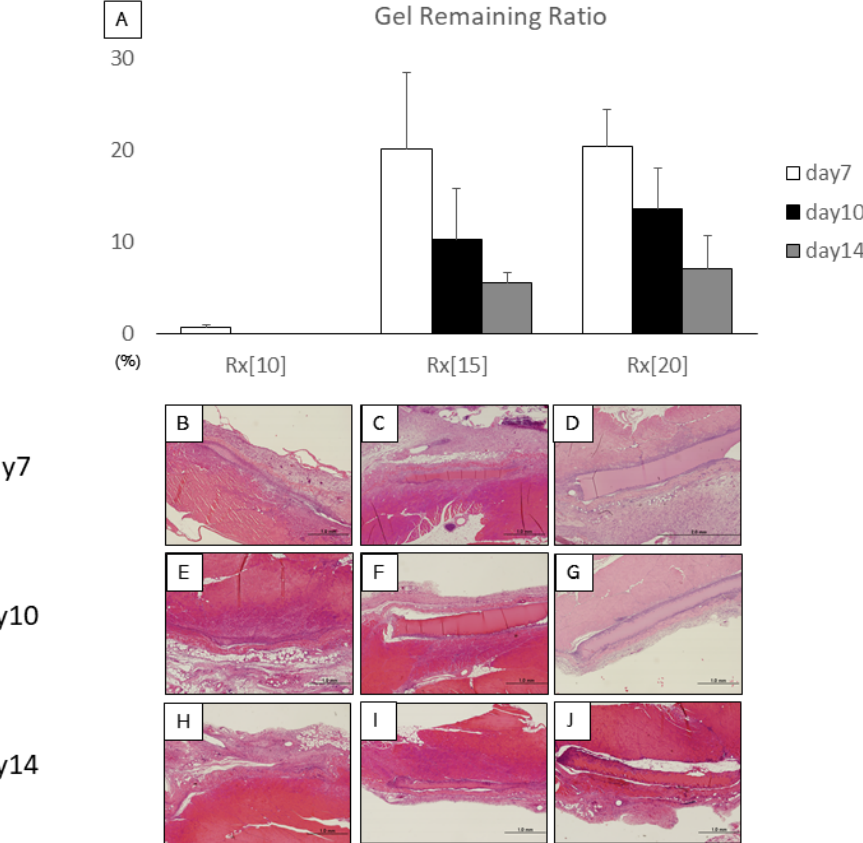
Figure 4. Hematoxylin and eosin (HE)-stained sections of implanted radiation-crosslinked hydrogels (RXgels): ( A ) Gel remaining ratioof RXgel analyzed by HE staining. There was no significant difference among other days in the same RXgel group; ( B – J ) HE staining of 5- μ m-thick sections on days 7, 10, and 14 after implantation of each RX-gel. With HE staining, RXgel was seen as a non-structural substance. Each scale bar indicates 1.0 mm.